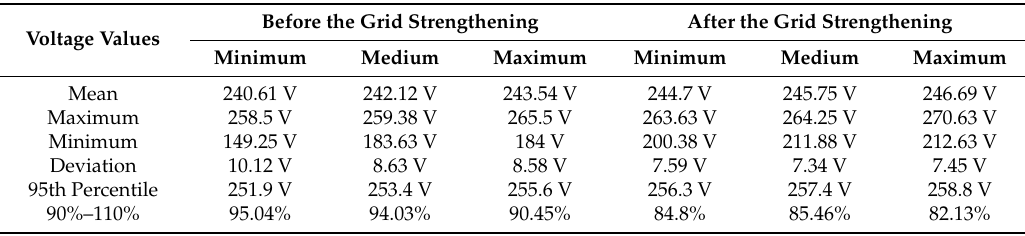
Table 1. Statistical analysis of data recorded during the four days of collecting data for both situations: before and after the grid strengthening.